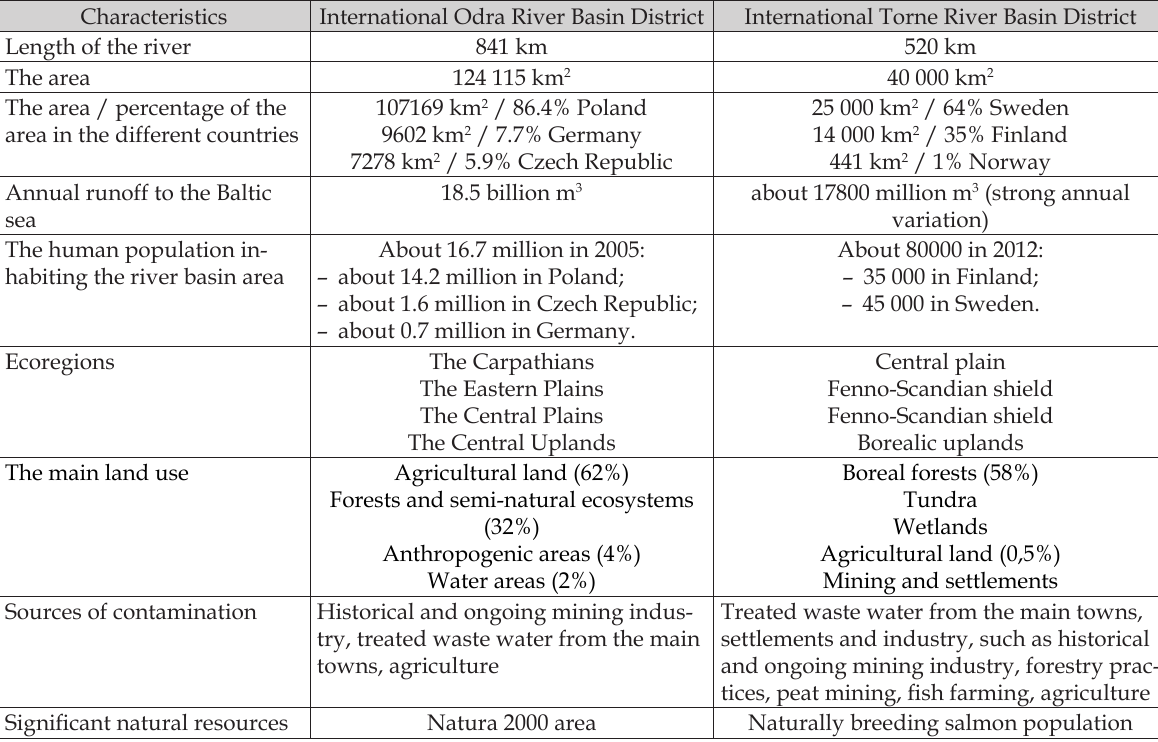
Table 1. Characteristics of the International Oder River Basin District (IORBD) and the International Torne Riv­ er Basin District (ITRBD) according to Elfvendahl et al. 2006, ICOP 2009, 2014, Öhman et al. 2016.